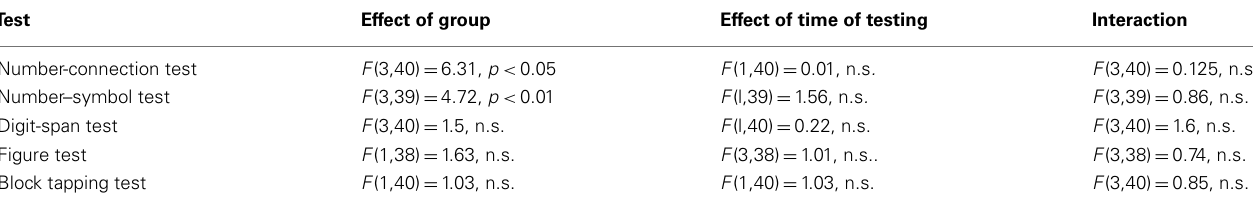
Table 2 | Main effect in the cognitive measurements (cognitive speed and memory